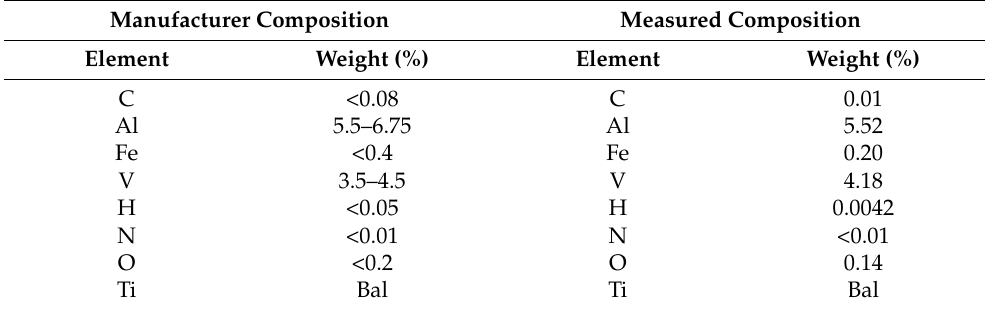
Table 1. Composition of the workpiece Ti6Al4V alloy.